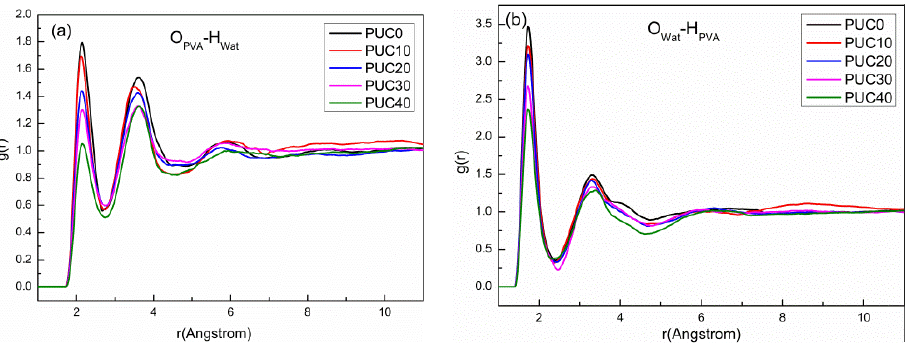
Figure 5. The RDFs between PVA and water molecules: ( a ) O PVA ‐ H Wat and ( b ) O Wat ‐ H PVA . With the increase in the UC content, the values of the peaks representing the formation of the hydrogen bonds in the RDFs of O PVA -H Wat and O Wat -H PVA decreased, but the positions remained constant. This means that the addition of UC decreased the possibility of hydrogen bonding between O PVA -H Wat and O Wat -H PVA , but the bond length did not size of the RDF, the probability of hydrogen bonding between O Wat -H PVA was higher than that of O PVA -H Wat . In addition, the hydrogen bond length of O PVA -H Wat was